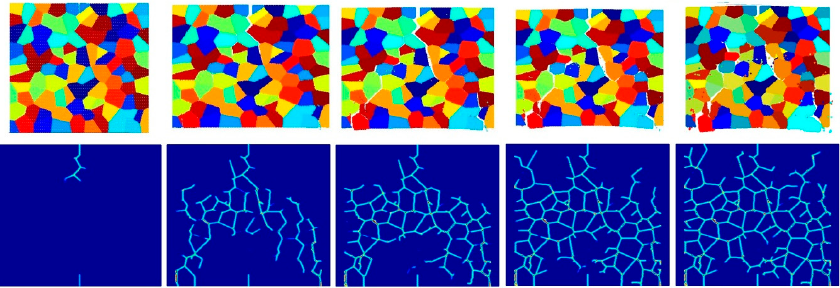
Figure 16. Fracture pattern of polycrystal when β = 0.5 with 300 × 300 particles. From left to right: time = 1.5 μ s, 2.0 μ s, 2.5 μ s, 3.0 μ s, and 3.5 μ s, respectively.